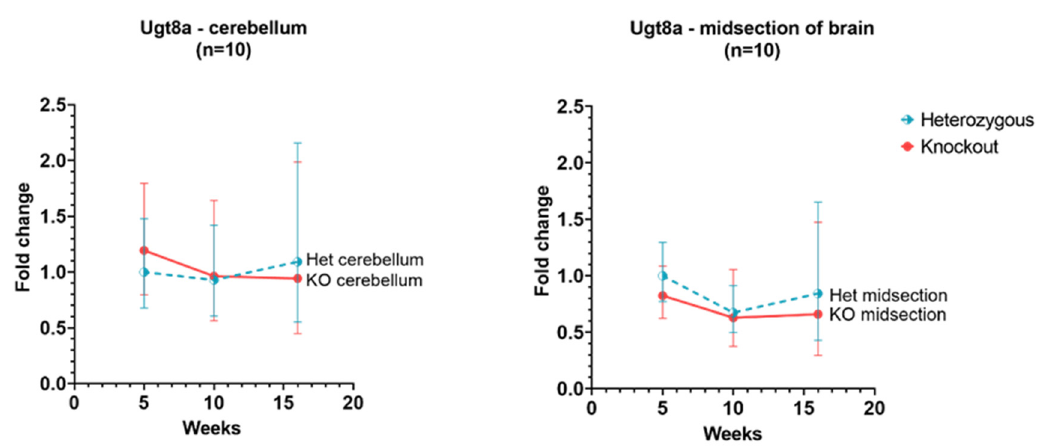
Figure 5. Relative Ugt8a expression in the cerebellum and cerebral cortex of Hexb-KO Sandhoff disease mouse model (midsection of brain represents cerebral cortex).